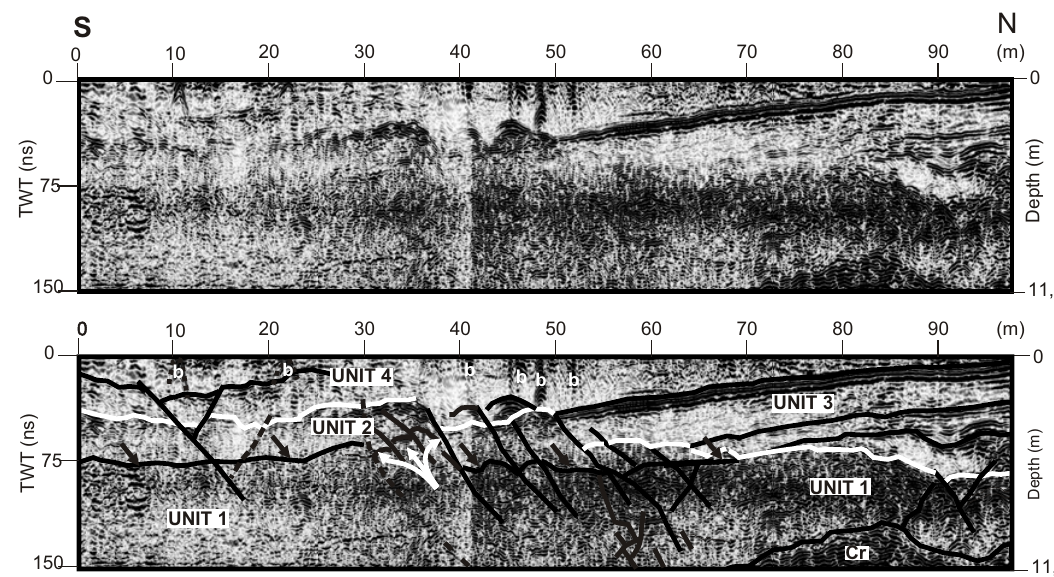
Fig. 5 – Non-annotated (upper) and annotated (lower) GPR section from the Atalaia Beach area, illustrating deposits correlatable to the Miocene (below white line) with reflections strongly disrupted by faults (continuous inclined black line = fault; hatched inclined black line = possible fault; white arrow = inverse fault; set of arrows above unit 2 = possible paleosoil horizon cemented by iron; b = large boulder/cobble or man artifacts; Cr = calcareous rocks). See text for further